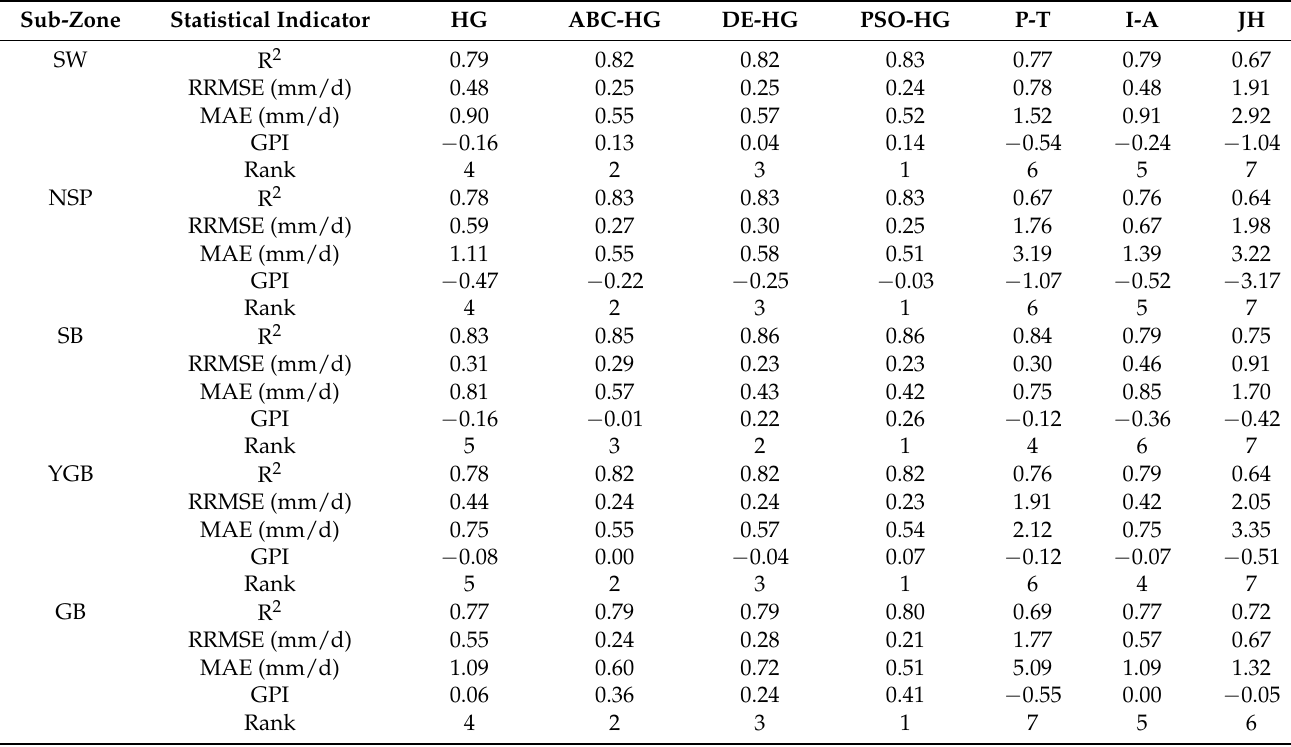
Table 3. The daily ET 0 accuracy estimated based on ABC, DE and PSO optimization algorithms in Southwest China.